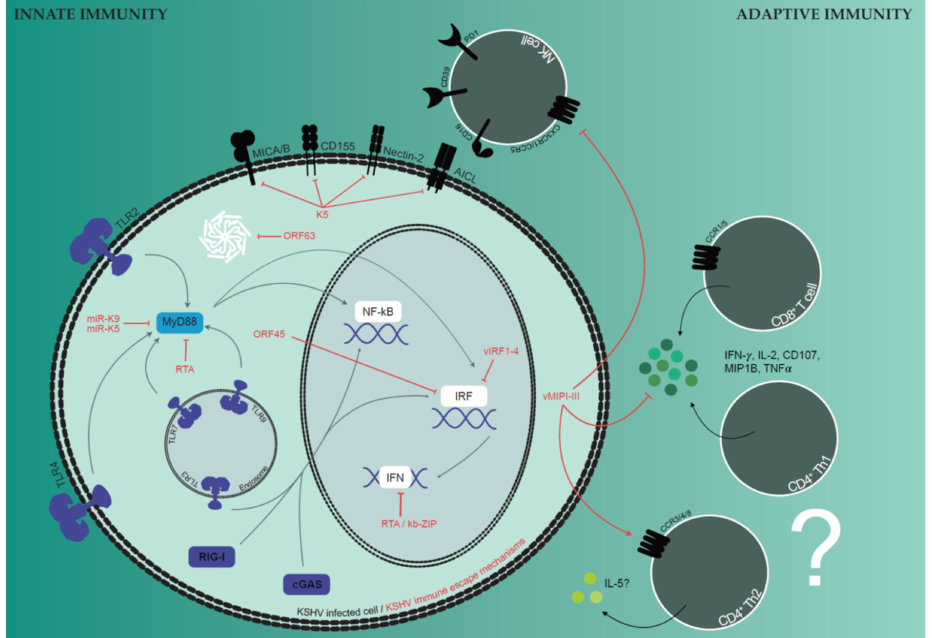
Figure 2. Balance between host immune responses and viral immune modulation mechanisms allow persistence of KSHV. TLR, RLR, NLR and intracellular DNA-sensor cGAS are the four PRRs reported to sense KSHV infection (blue) and to induce NF- κ B-mediated inflammatory cytokine production, type I IFN response and inflammasome activation (white). KSHV immune evasions (red) counteract PRR-induced signaling pathways via different means, e.g., via reducing the expression of signaling proteins (miR-K9/K5, RTA, kb-ZIP), via suppression of cellular proteins by viral homologues (vIRF1- 4, ORF63), via targeting signaling proteins for proteasomal degradation (RTA) or via inhibition of nuclear translocation of signaling proteins (ORF45). Cellular innate immune response is modulated by reducing cytotoxicity of NK cells via driving differentiation into a late phenotype characterized by CD39 expression and loss of NKG2D, via downregulation of activating NK cell receptor ligands and via inhibiting NK cell migration by viral chemokine secretion. IFN- γ derived from NK cells, CD8 + or Th1 CD4 + T cells might protect from KSHV-associated malignancies, although T cell correlates conferring protection from KSHV-associated malignancies are not fully